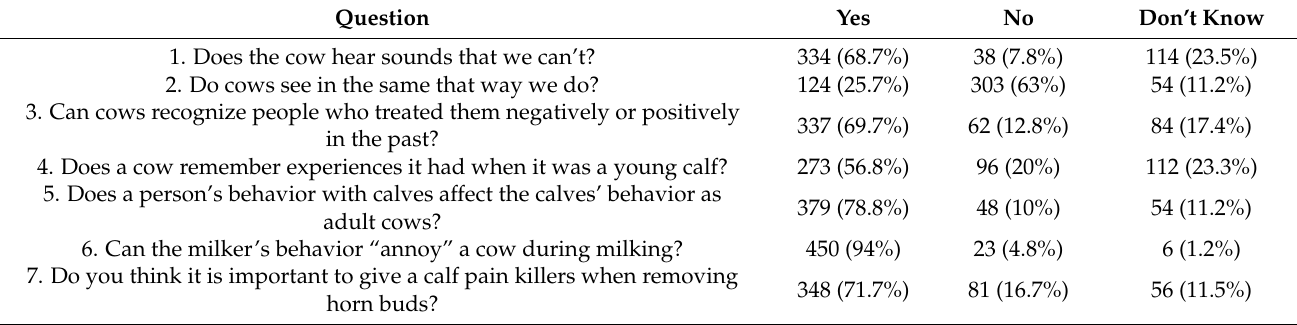
Table 2. Distribution of dairy farm workers’ answers to questions regarding cow senses and memory, human–cow interactions, and pain perception ( n =